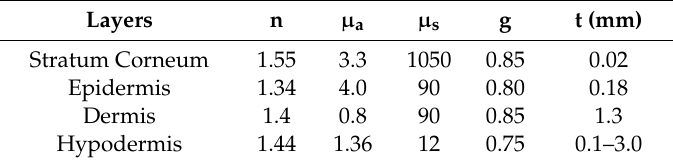
Table 1. Optical parameters of skin layers at λ = 800 nm